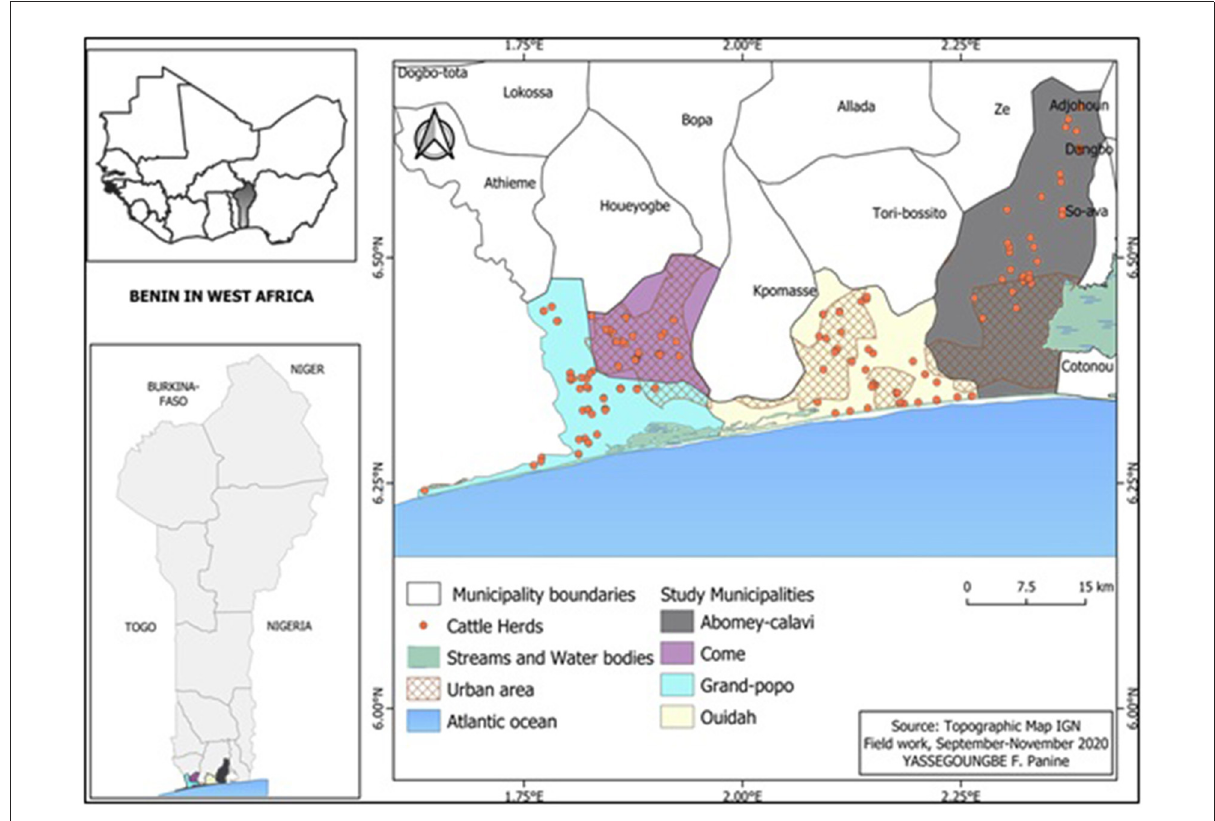
FIGURE1 Map of West Africa with Benin marked in gray (upper left), Benin country (lower left) and the coastal region of Benin (right) showing the four studied municipalities and surveyed cattle herds.